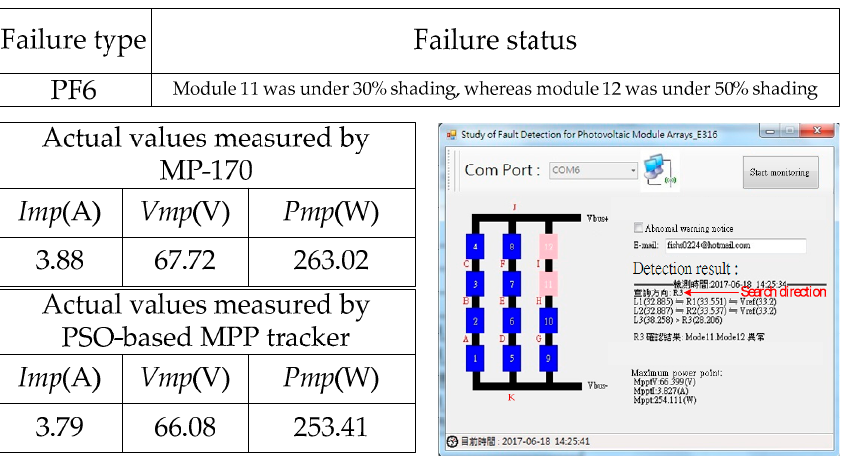
Figure 21. Experimental outcome for failure type PF6.